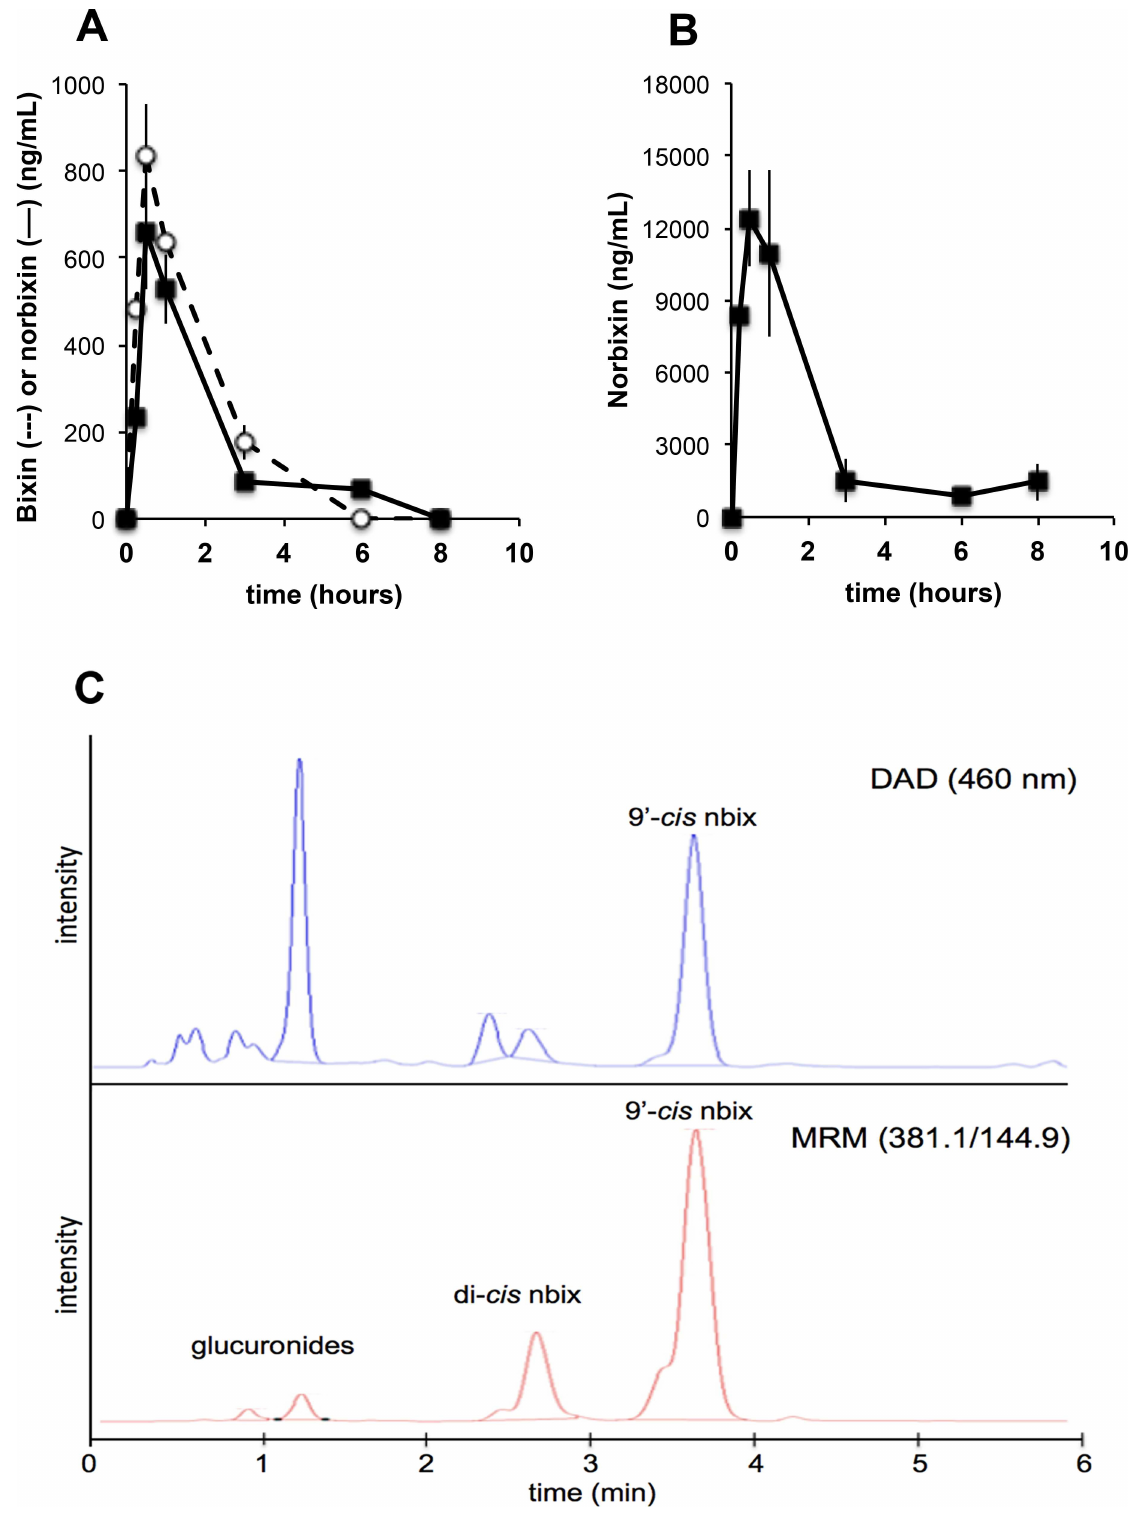
Fig 4. Comparative pharmacokinetics of bixin (A) and norbixin (B) given orally. (A) bixin or (B) norbixinwere given at 50 mg/kg. Plasma analyses—note that bixin is efficientlyconverted into norbixin(values are the mean of three different animals). ( C) HPLC-MS/MS analysisof a mouse plasma sample followingoral administration of 9’- cis -norbixin. Both norbixin isomers and glucuronideconjugates are observed. DAD: diode-array detector; MRM: multiple reactionmonitoring. doi:10.1371/journal.pone.0167793.g004 PLOS ONE | DOI:10.1371/journal.pone.0167793 December16,